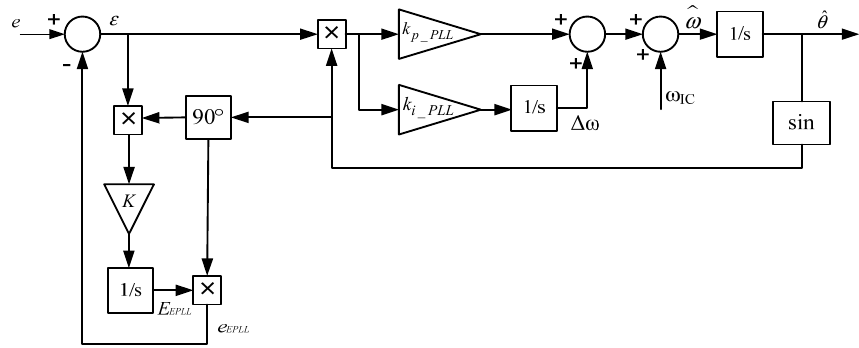
Figure 7. Enhanced phase-locked loop (EPLL) structure.